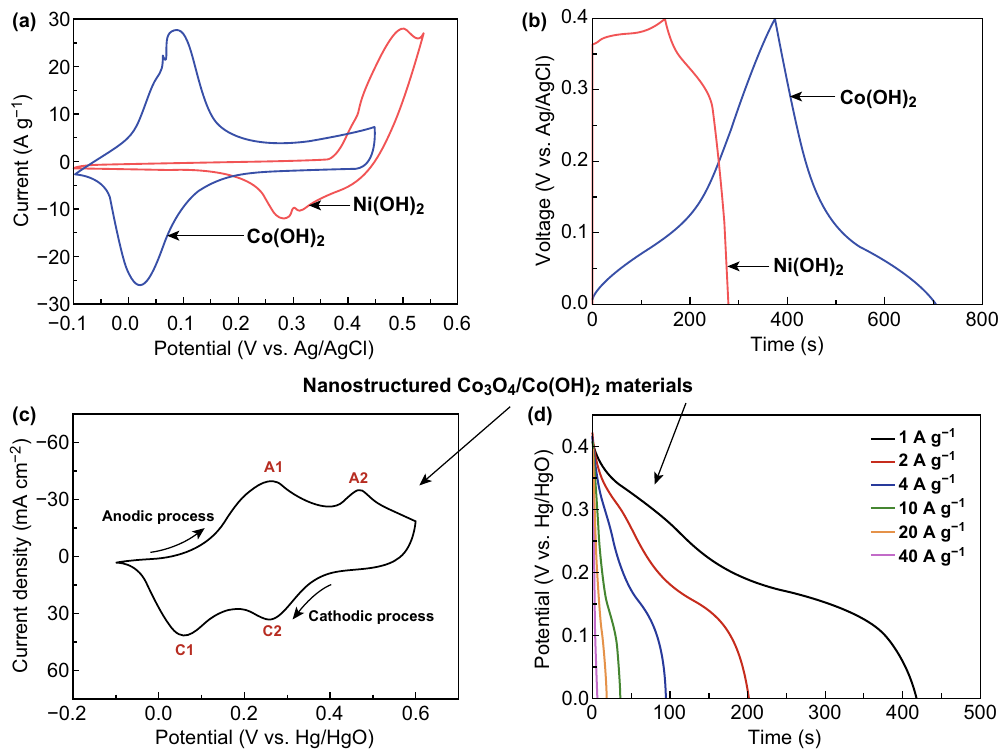
Fig. 26 a CV curves and b galvanostatic charge–discharge profiles of Co(OH) 2 (blue) and Ni(OH) 2 (red). c CV curves and d galvanostatic charge–discharge profiles of Co 3 O 4 /Co(OH) 2 core/shell nanowire arrays. Adapted from a , b Ref. [255], c , d Ref. [267] with